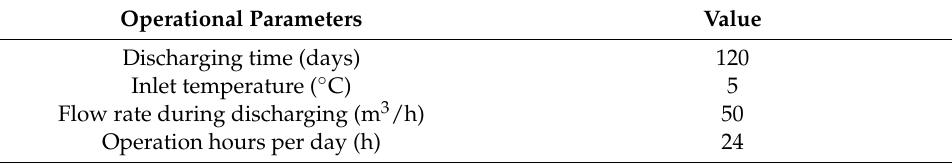
Table 4. Operational parameters for the deep BTES during discharging.